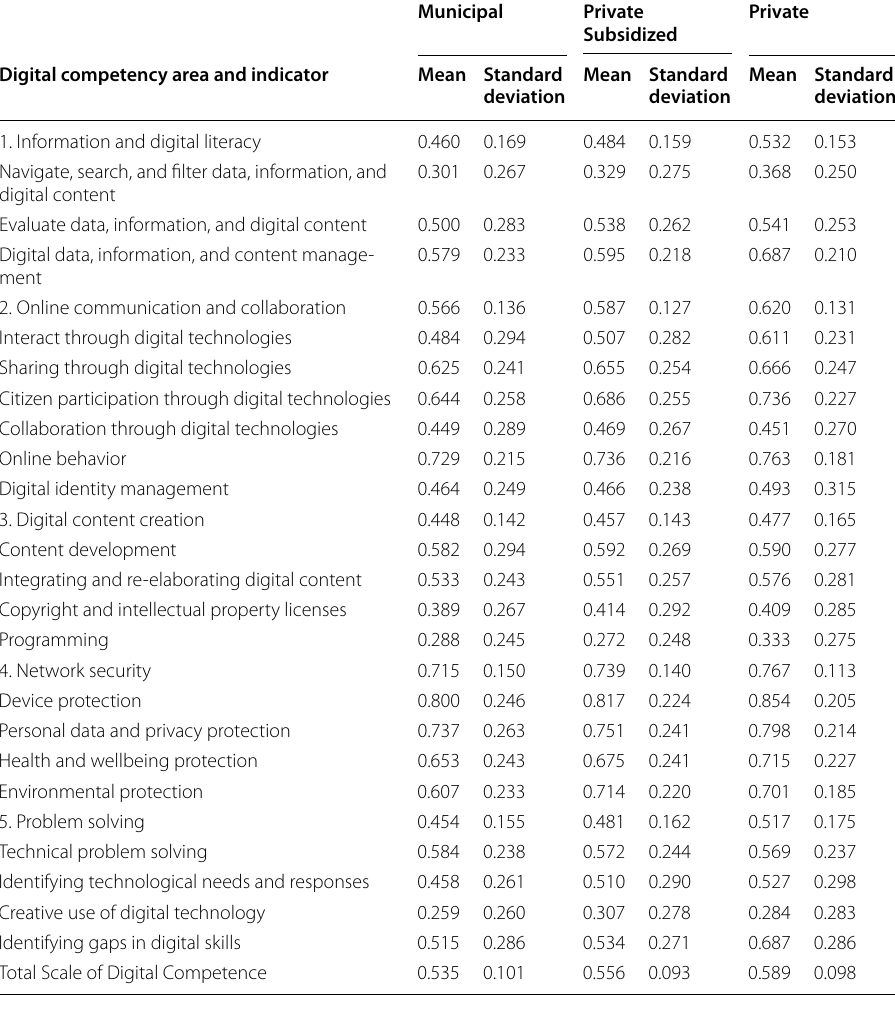
Table 4 Digital Competence level by type of establishment. Source: Prepared by the author Digital competency area and indicator Mean Standard